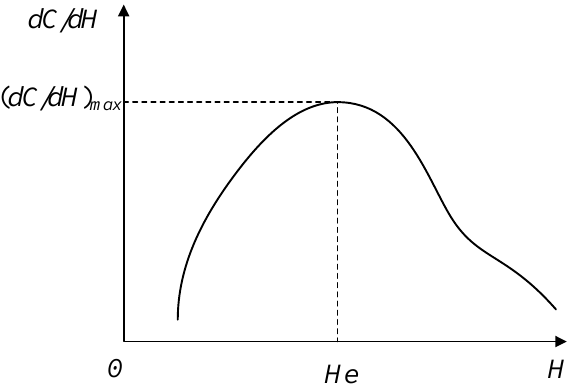
Figure 3. Sketch of the landscape connectivity approach for determining the minimum ecological lake level.